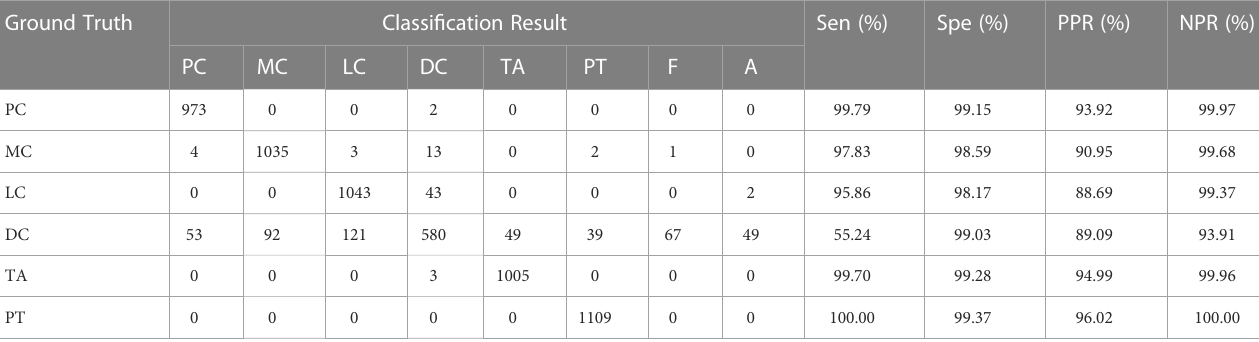
TABLE 8 Confusion matrix of binary classi fi cation results and values of evaluation metrics. ((d, n) = (26, 222)). Sen, sensitivity; Spe, speci fi city; PPR, positive prediction rate; NPR, negative prediction rate; A, Adenosis; F, Fibroadenoma; PT, Phyllodes Tumor; TA, Tubular Adenoma; DC, Ductal Carcinoma;